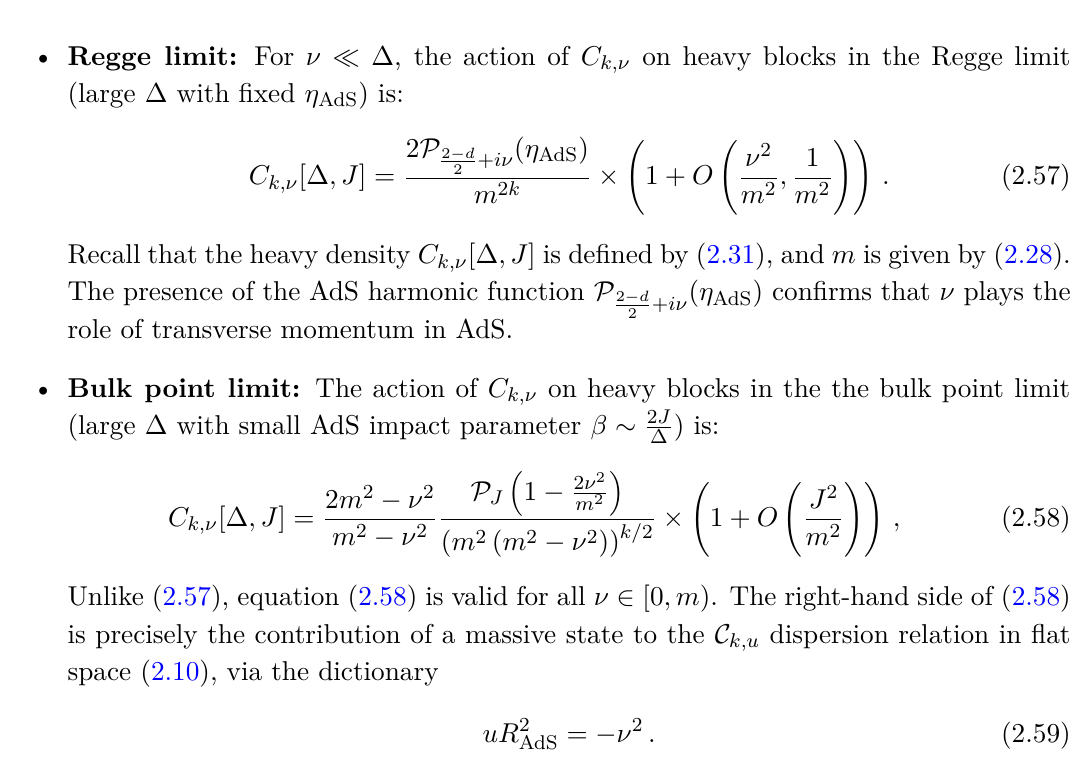
Figure 5. In the CFT, the angle of approach η to the Regge limit (in which operators 3 and 4 become null from 1 and 2, respectively) acts as a smeared version of the bulk impact parameter η AdS = cosh β . Since both variables transform like hyperbolic cosines under SO( d − 1 , 1) transverse isometries, shown as blue and red arrows, harmonic analysis can be used to “undo” the smearing and achieve bulk focusing. The operators always stay within the “Rindler wedge” in which 1 is spacelike from 3 (and 4 is spacelike from 2